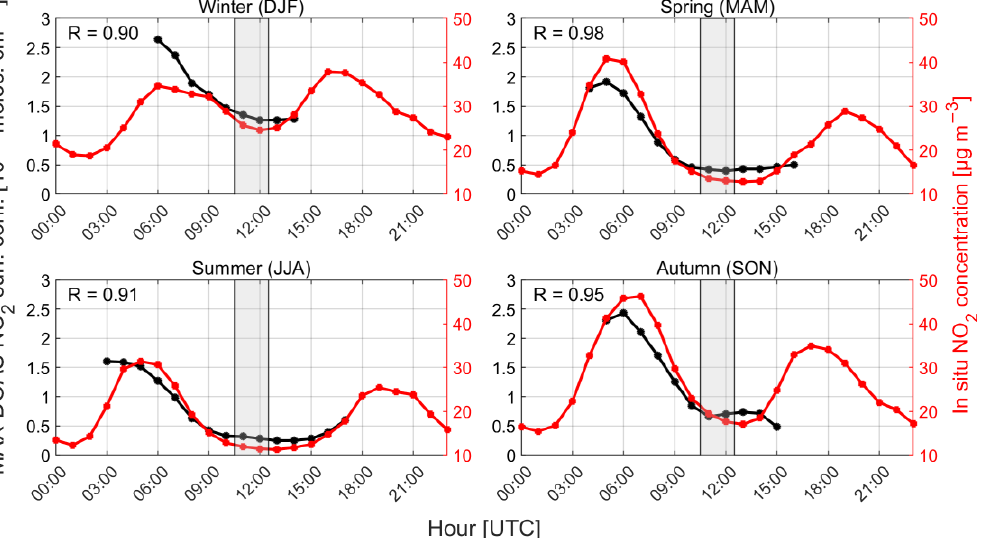
Figure 3. The diurnal variability of NO 2 surface concentrations revealed by the MAX-DOAS (black) and the in situ (red) measurements for all seasons. The gray-shaded rectangles indicate the range of S5P/TROPOMI overpass times for Thessaloniki.